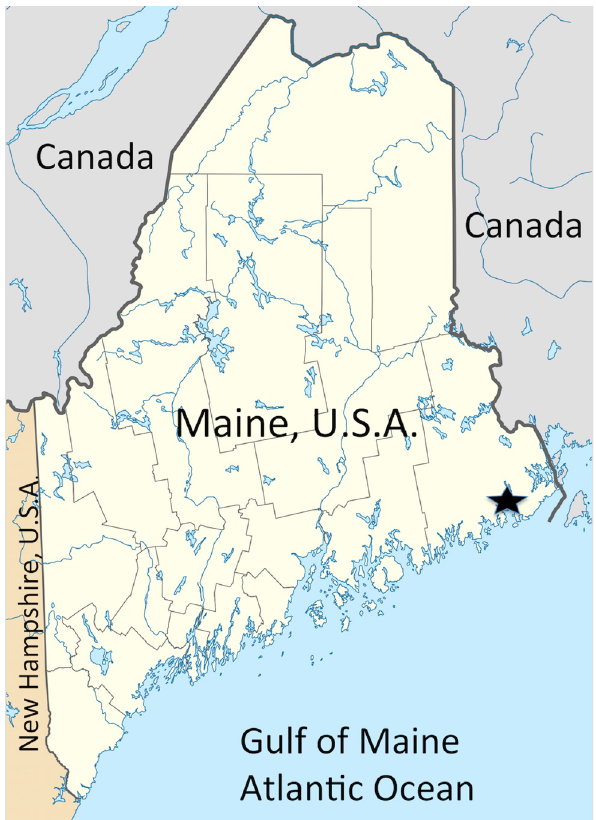
Figure 2: Map of site location. Blueberry Hill Farm is the University of Maine’s lowbush blueberry research farm and the site of this study. Its location is indicated on the map with a black